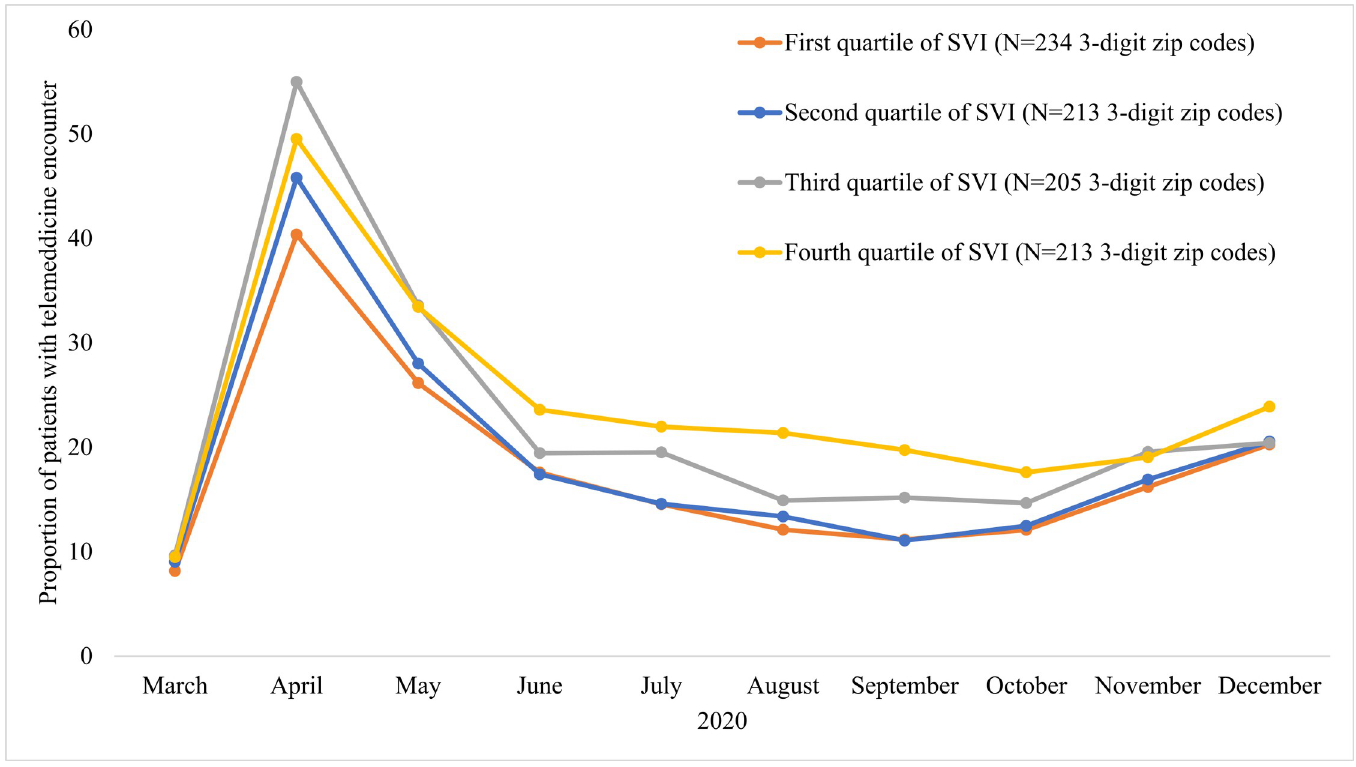
Fig 2. Monthly proportion of unique patients with outpatient telemedicine encounter from March to December 2020 by Social Vulnerability Index of 3-digit ZIP code of residence. Social Vulnerability Index (SVI) based on Centers for Disease Control and Prevention methodology [9]. A higher value of SVI indicates greater degree of social vulnerability of an area to a health disaster. Patients with telemedicine encounters in one month, not included in calculation for subsequent months.